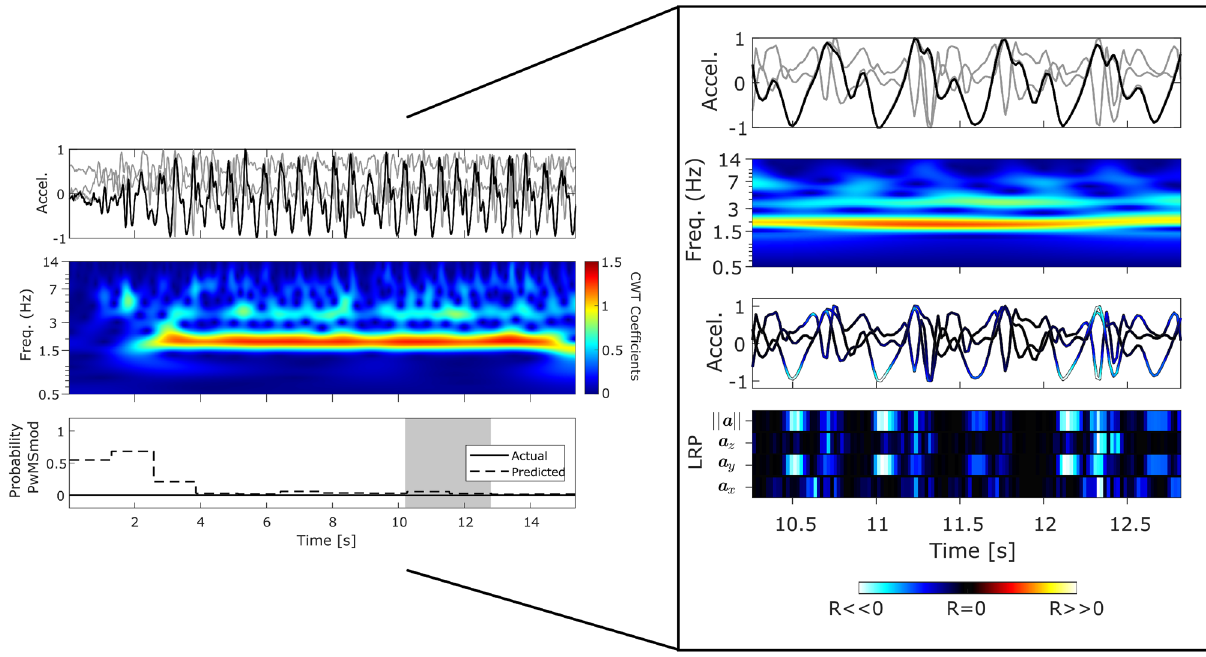
Figure 2. HC epoch: Panel plot illustrating example performance of a typical HC subject (true negative) which can be visually interpreted using LRP decomposition and CWT frequency analysis. (HC, T25FW: 4.8 ± 0.35) The top row represents a 3-axis accelerometer trace captured from a smartphone over 15.4 seconds, which corresponds to 12 epochs of length 128 samples (or 2.56 [s]) with a 50% overlap. The magnitude ( (cid:31) a (cid:31) ) of the 3-axis signal is highlighted in bold. The second row depicts the top view of the CWT scalogram of (cid:31) a (cid:31) , which is the absolute value of the CWT as a function of time and frequency. The final row depicts the output disease classification probabilities ( T T ). The shaded grey area represents an example epoch (n=128 samples, or 2.56 [s]) within the acceleration trace, which is examined in the larger subplot through the decomposition of DCNN input relevance values ( R i ) using Layer-Wise Relevance Propagation (LRP). Red and hot colours identify input segments denoting positive relevance ( R i > 0 ) indicating f ( x ) > 0 (i.e. MS). Blue and cold hues are